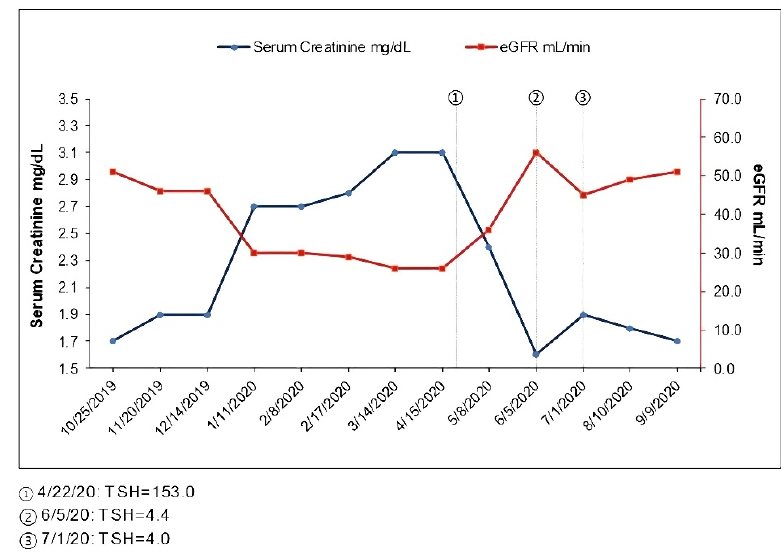
Figure 1. Time course of serum creatinine and thyroid